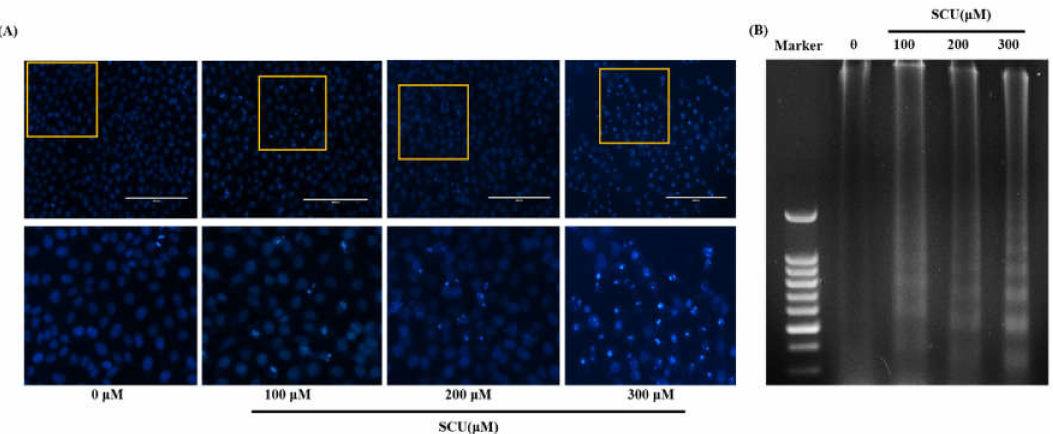
Figure 4. Nuclear morphological changes on scutellarein (SCU)-treated Hep3B cells. Hep3B cells were treated with SCU at indicated concentrations (100-, 200- and 300- µ M) for 24 h. ( A ) After fixation, the cells were stained with 4 (cid:48) -6-diamidino-2-phenylindole (DAPI) to observe fragmented chromatin and apoptotic bodies. ( B ) DNA was isolated and electrophoresed in 1.5% agarose gel to confirm DNA